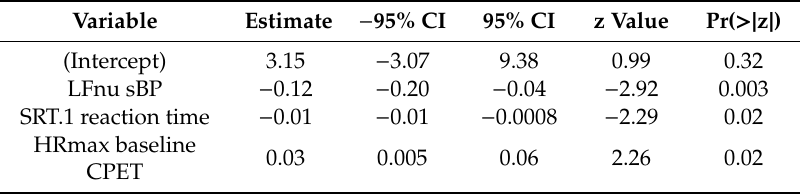
Table A1. Logistic regression coe ffi cients predicting SEP